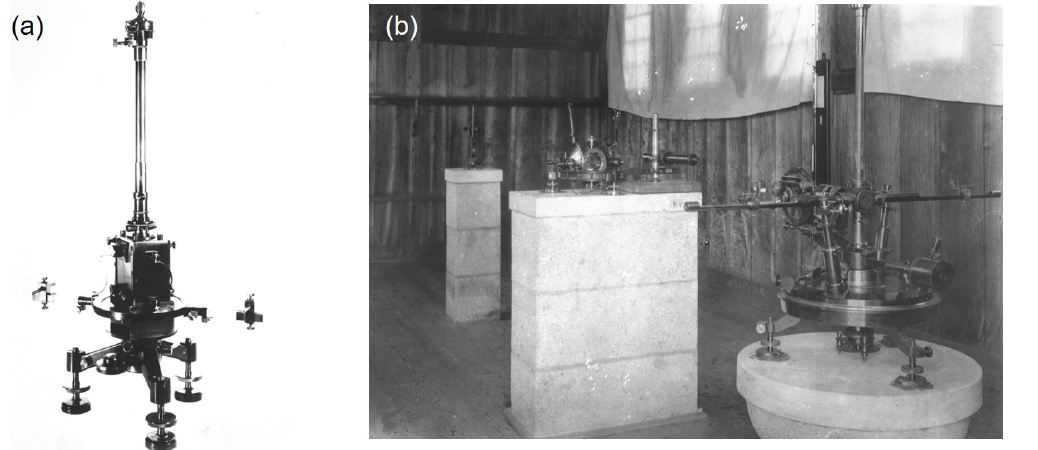
Figure 5. Instruments for the geomagnetic field measurement. (a) The Eschenhagen variometer for the horizontal component and the (b) Wild–Edelmann theodolite (right) and Edelmann earth inductor (center) (photo supplied by Kakioka Magnetic Observatory).